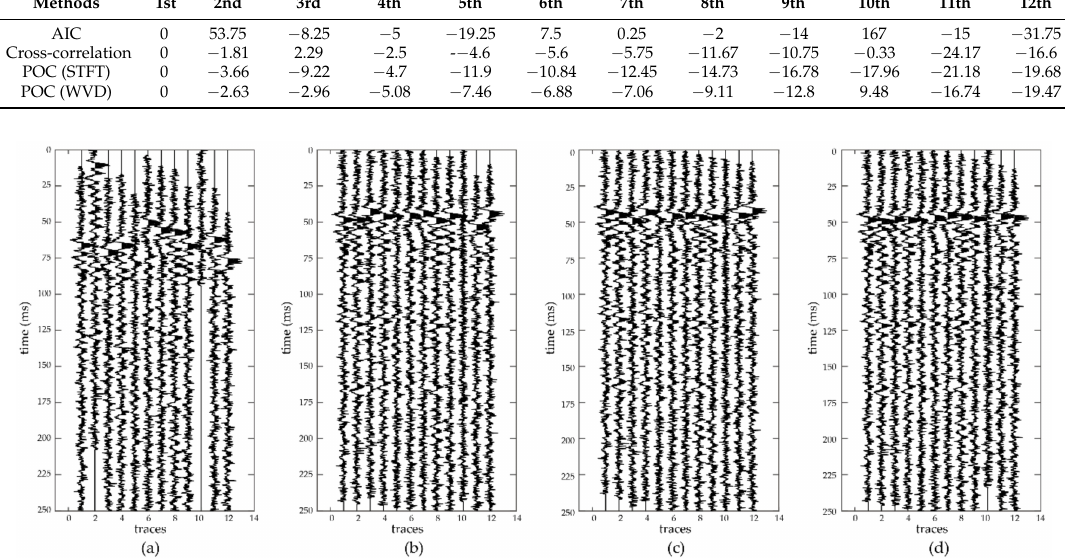
Figure 12. Using estimation values of the relative arrival times to eliminate the arrival time difference among the traces of the third noisy data. ( a ) The result based on AIC; ( b ) the result based on cross-correlation; ( c ) the result based on POC (STFT); and ( d ) the result based on POC